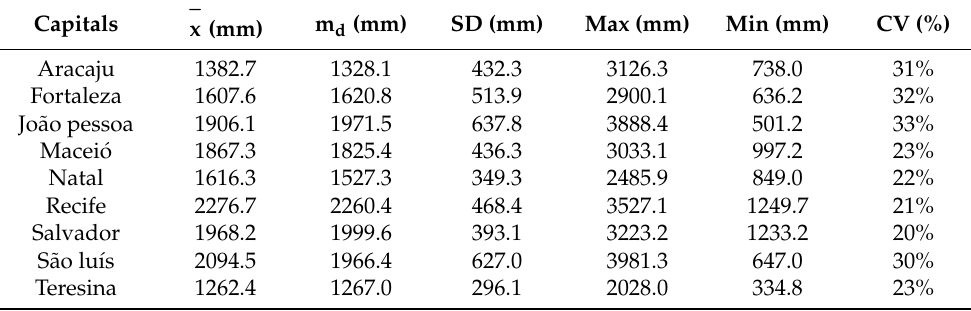
Table 5. Descriptive statistics applied to annual rainfall (mm) in NEB